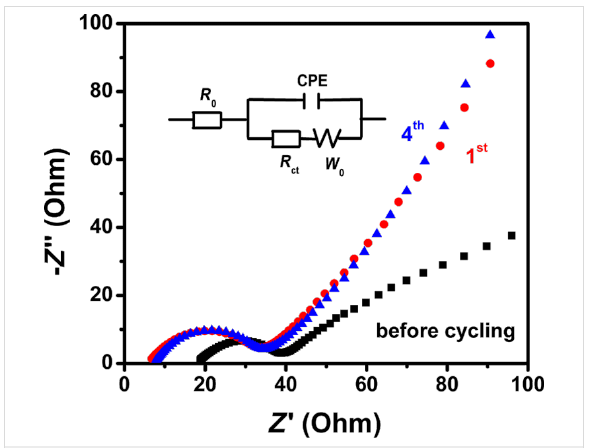
Figure 8: Nyquist plots of S-3D-RGO@MWCNT cathode and the equivalent circuit model (inset).